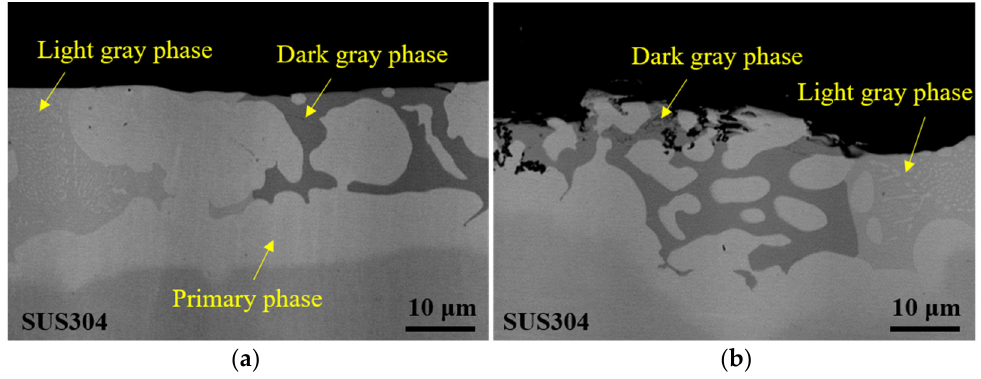
Figure 12. BSE images of cross sections of brazed Ni-13.4Cr-11.6P alloy coating. ( a ) Before galvanic current measurement; ( b ) after galvanic current measurement.